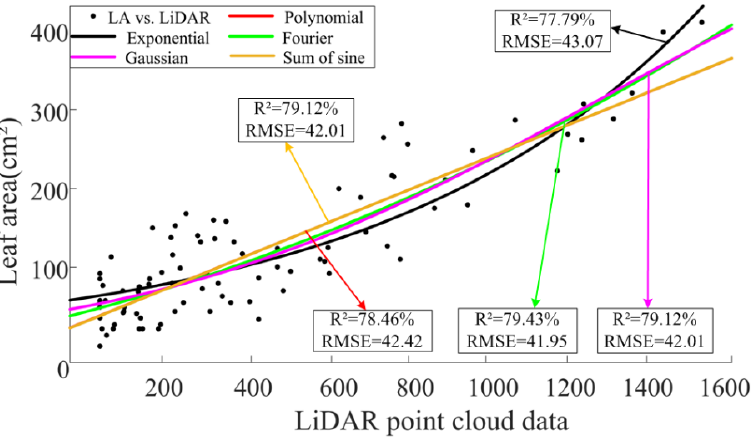
Figure 10. Comparison of fitting equations of test data.